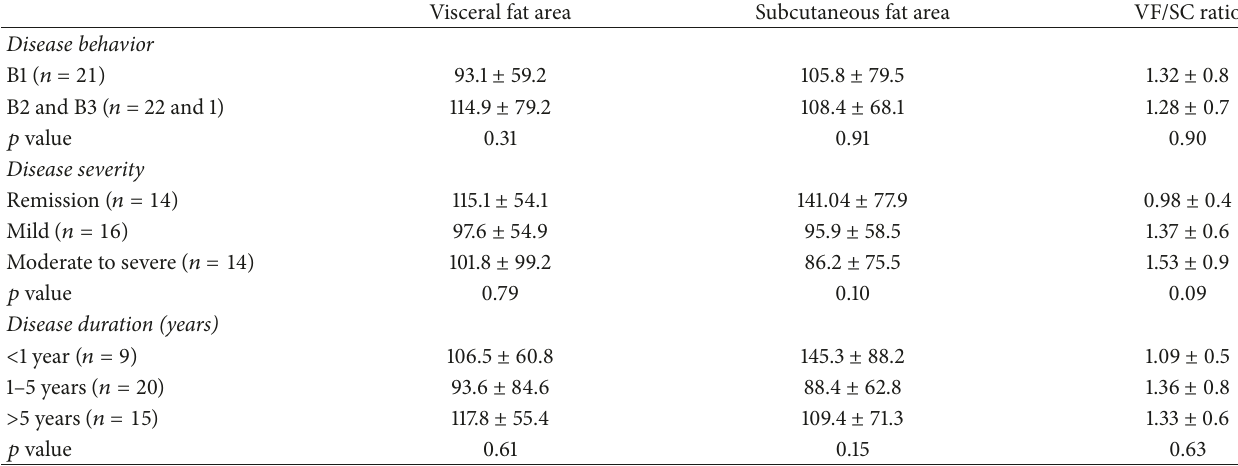
Table 5: Effect of disease behavior, clinical severity, and disease duration on visceral and subcutaneous fat area and visceral to subcutaneous fat ratio